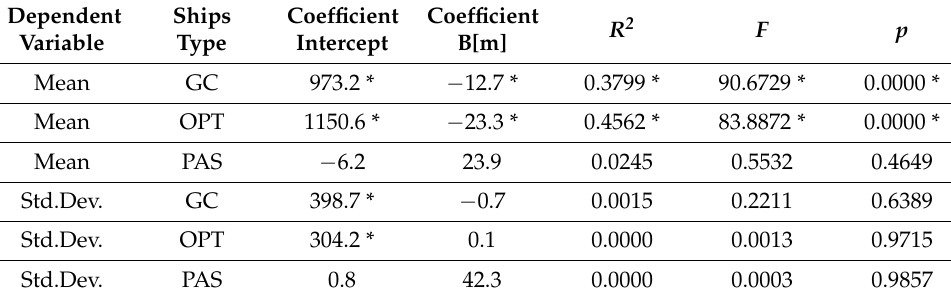
Figure 9. Mean of ships distance from the centre to the width of the ship. Table 2. The parameter of simple regression